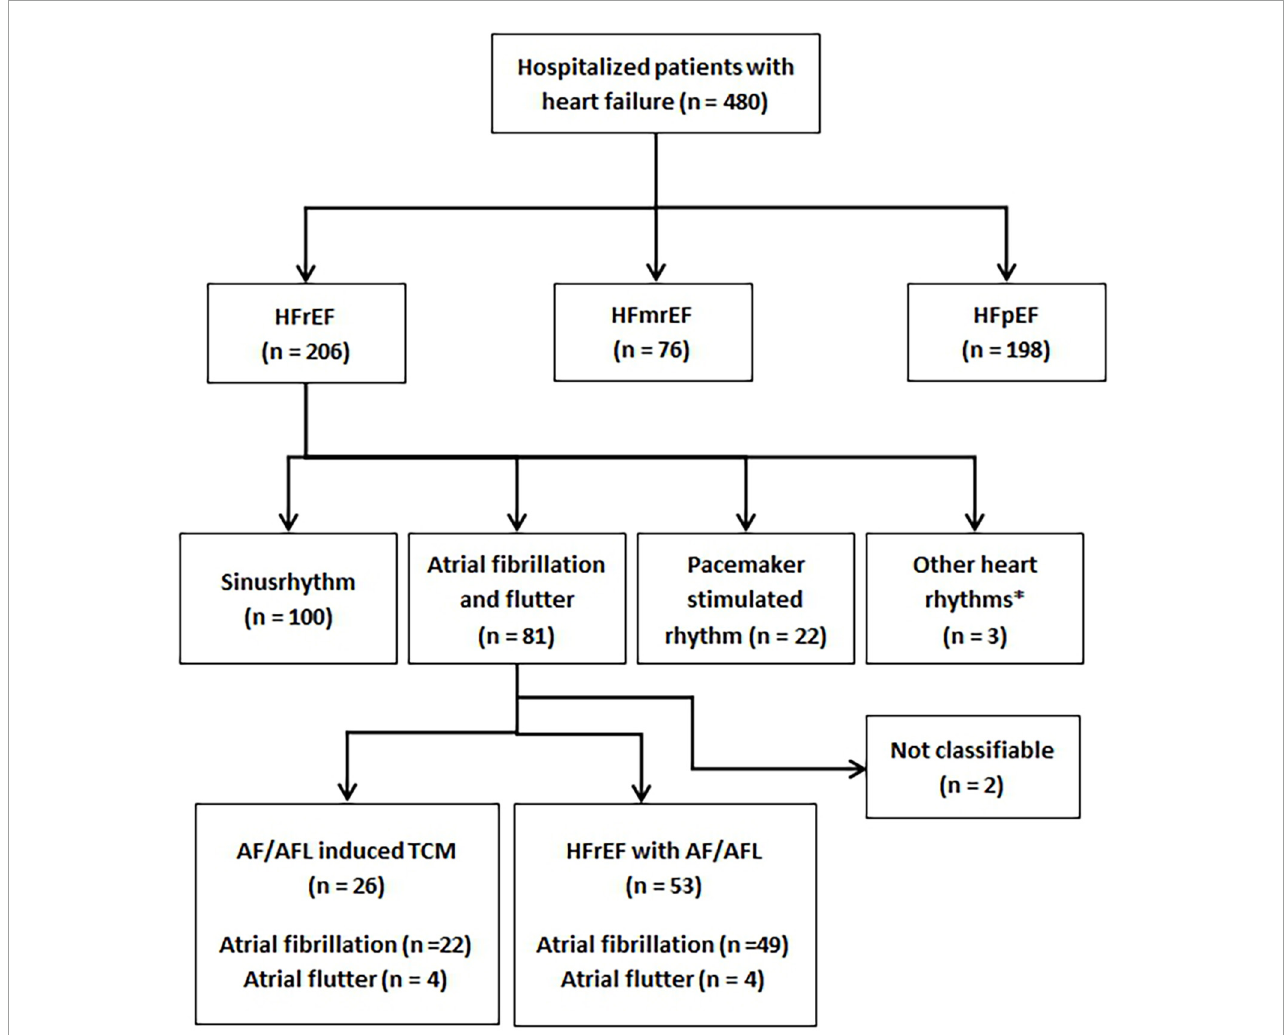
FIGURE1 Flowchart demonstrating all patients diagnosed with heart failure during the study period and subgroups of patients. HFrEF, heart failure with reduced ejection fraction; HFmrEF, heart failure with mildly reduced ejection fraction; HFpEF, heart failure with preserved ejection fraction; TCM, tachycardiomyopathy; AF/AFL, atrial fibrillation or atrial